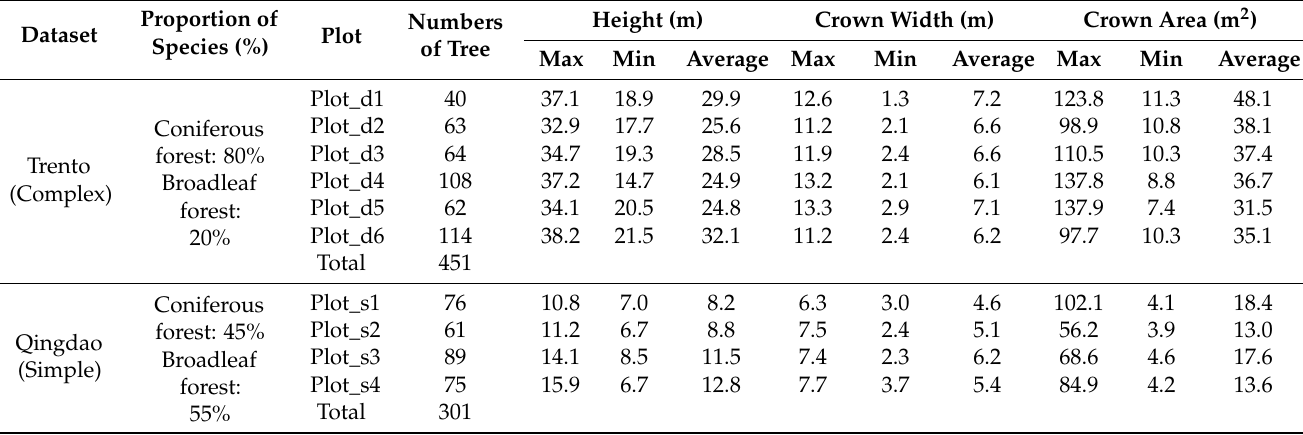
Table 1. Tree information of the ten experimental